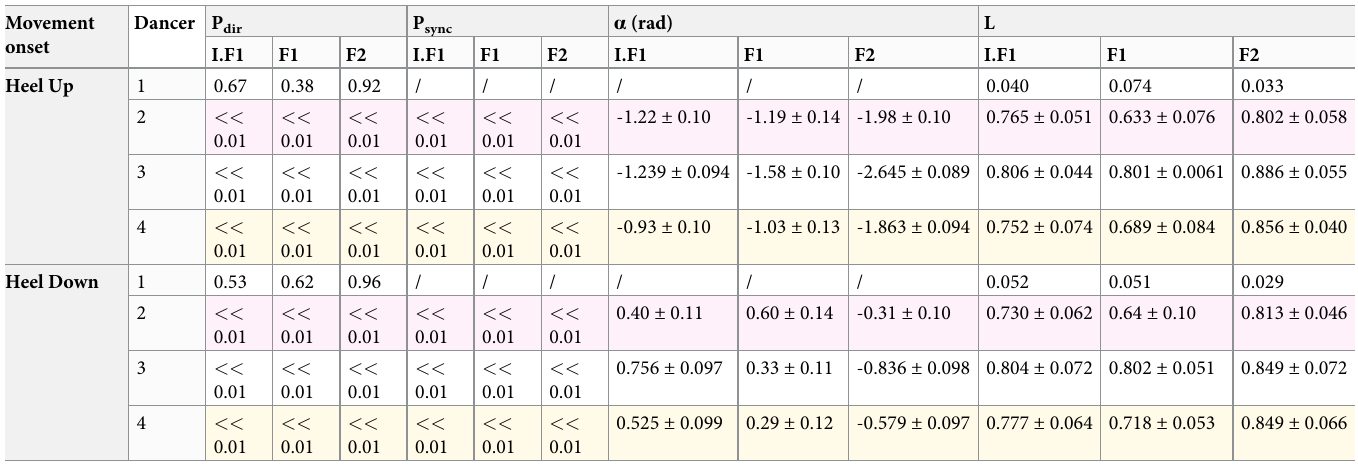
Table 1. Results of circular statistics